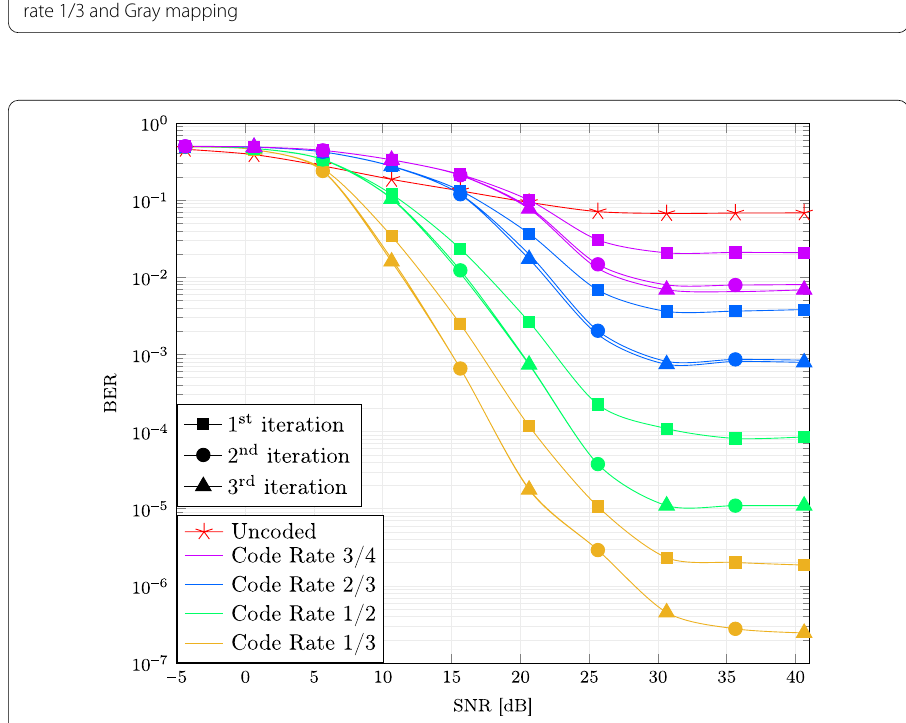
Fig. 11 BER results for the considered CPM system using different code rates and Gray